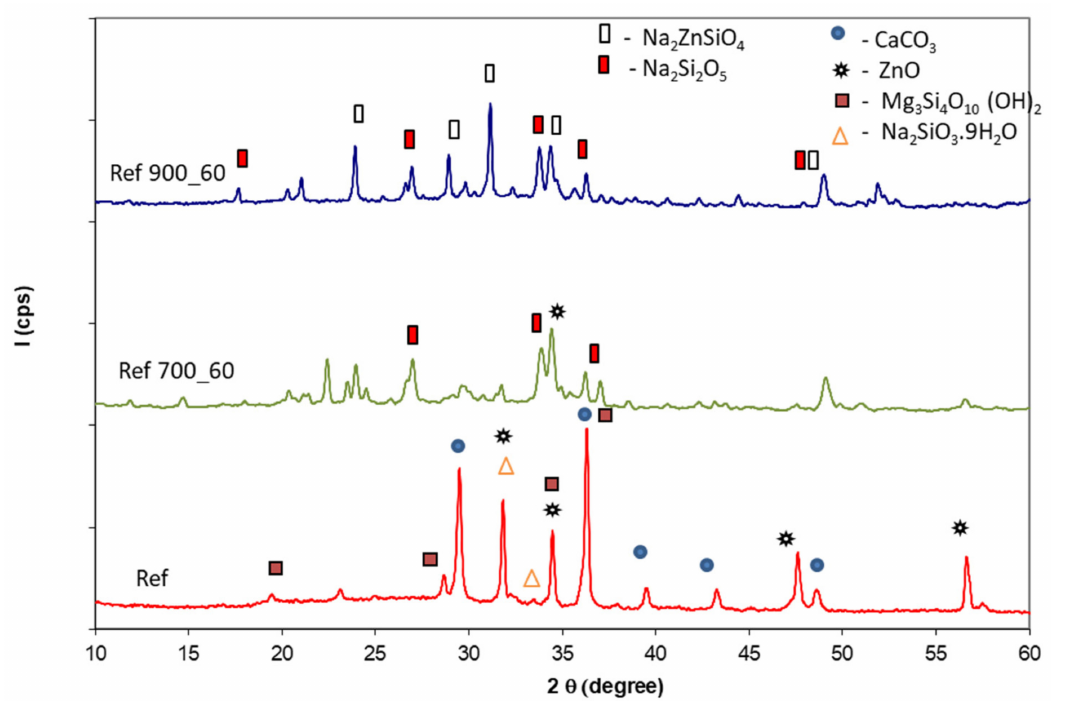
Figure 5. XRD patterns of reference coating before and after thermal treatment at 700 ◦ C and 900 ◦ C for 60 min.